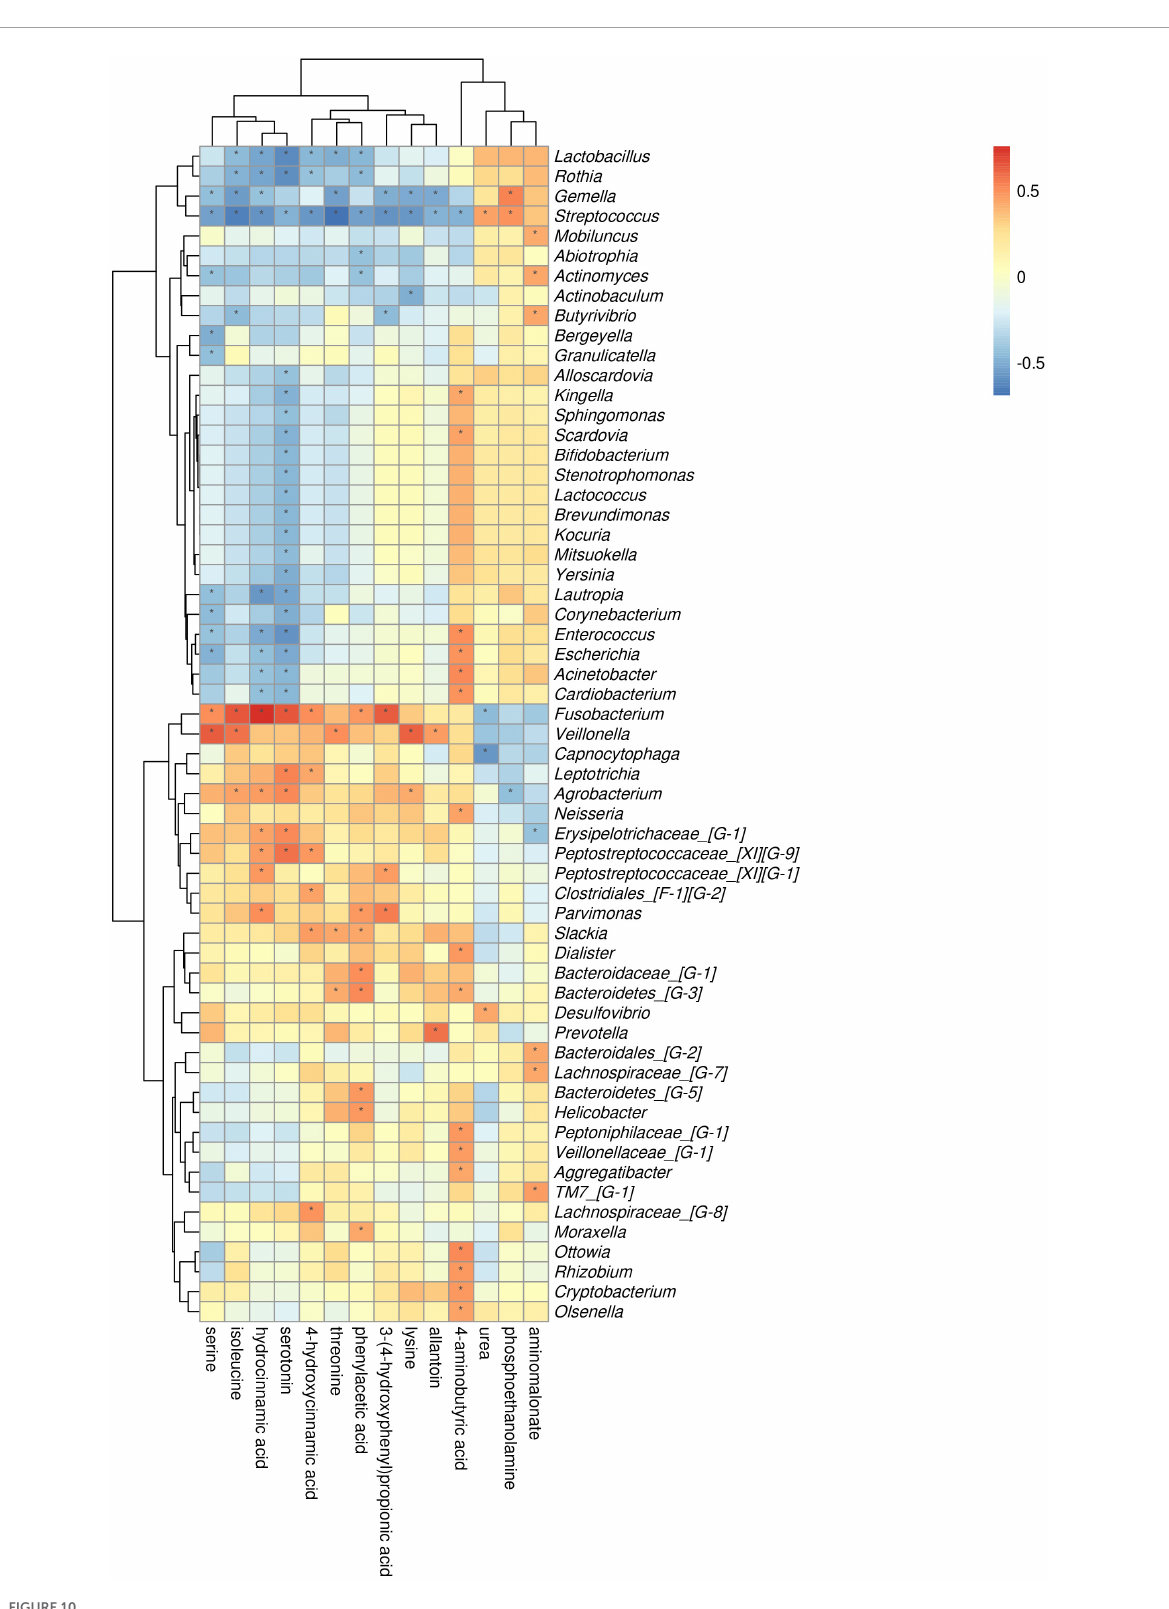
FIGURE10 Association of microbial genera with differential metabolites in ChP and